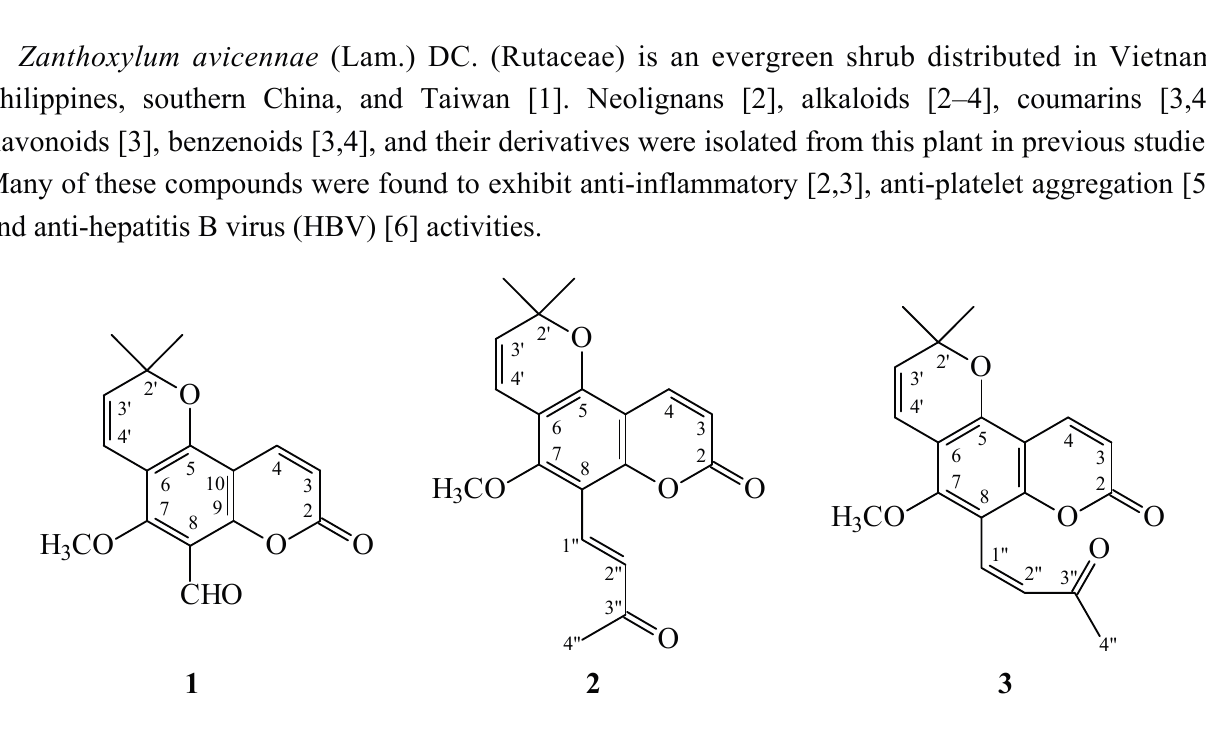
Figure 1. The chemical structures of new compounds 1 – 3 isolated from Z. avicennae